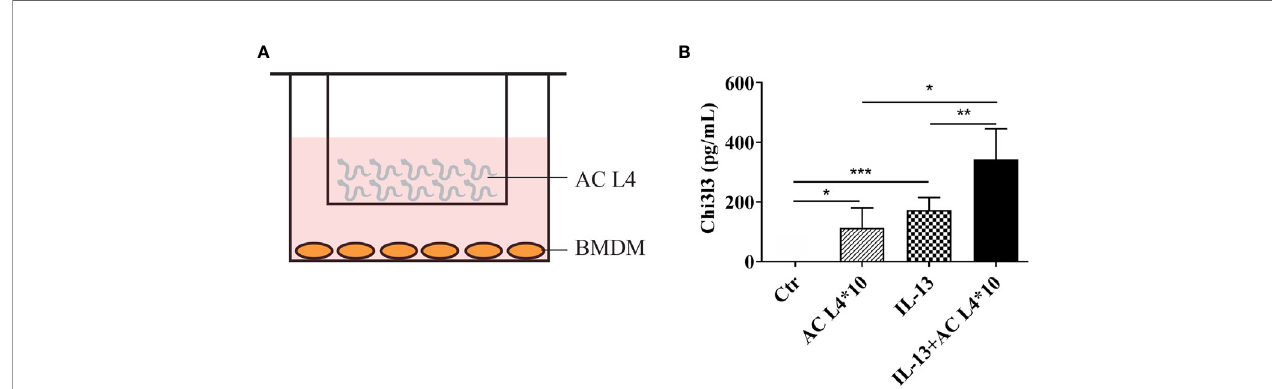
FIGURE 1 | Excretory-secretory products in AC L4 induce M2 polarization of macrophage. (A) Diagram of co-culture system with 10 AC L4 above the membrane and BMDMs below the membrane. (B) ELISA analysis of Chi3l3 of BMDMs in the presence of 10 AC L4, IL-13, and IL-13+10 AC L4 for 24 h. Data information: * P <0.05, ** P <0.01.